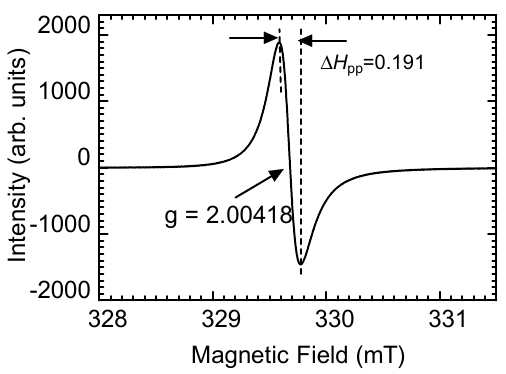
Figure 4. The electron spin resonance of the PANI SEA prepared using seawater as the solvent.